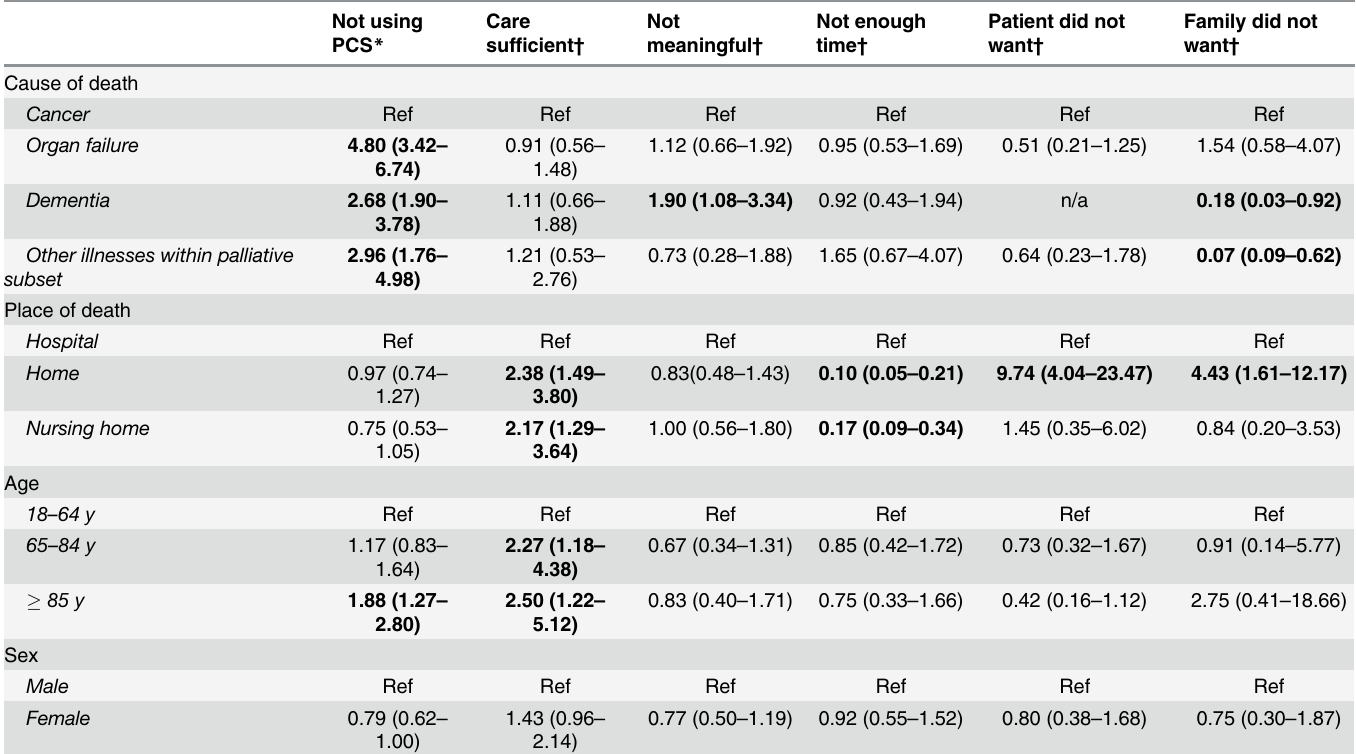
Table 4. Reasons given by physicians for not using specialist palliative care services (PCS) controlled for cause of death, place of death, sex and age: multivariate